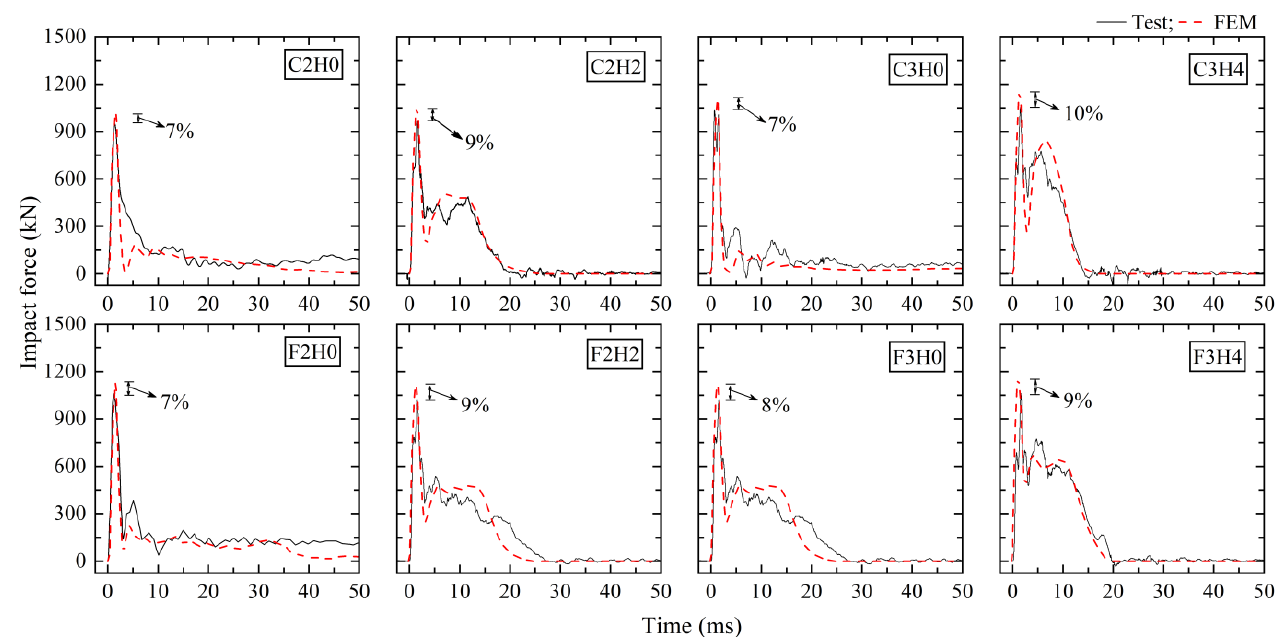
Figure 2. Comparison between numerical results and test results of impact force.